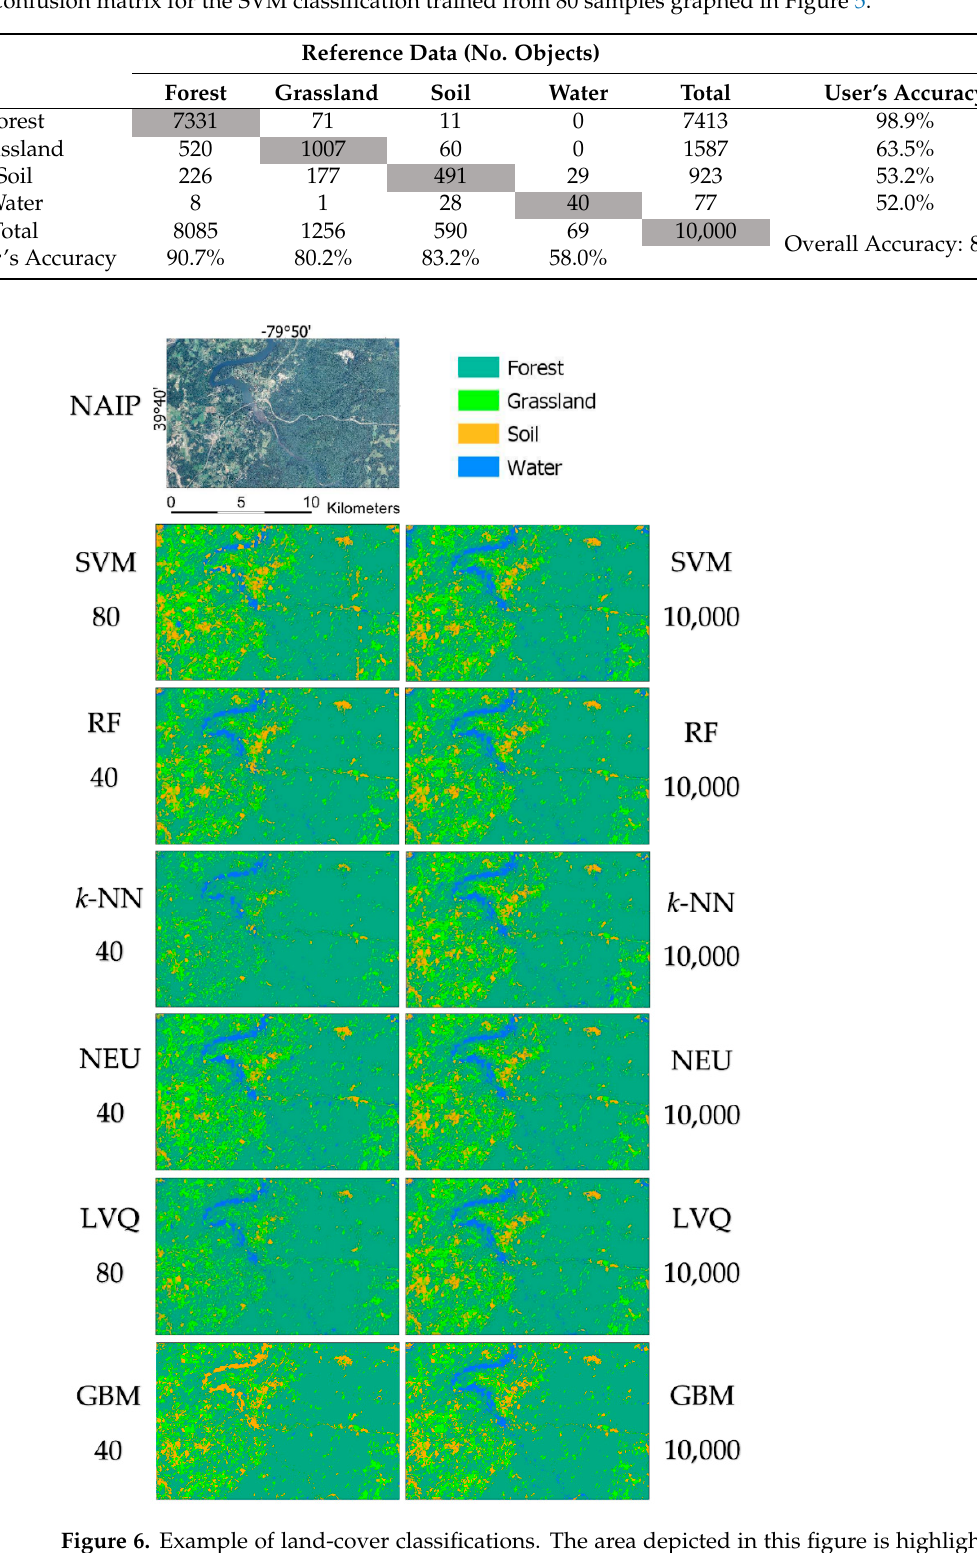
Table 8. Confusion matrix for the SVM classification trained from 80 samples graphed in Figure 5.